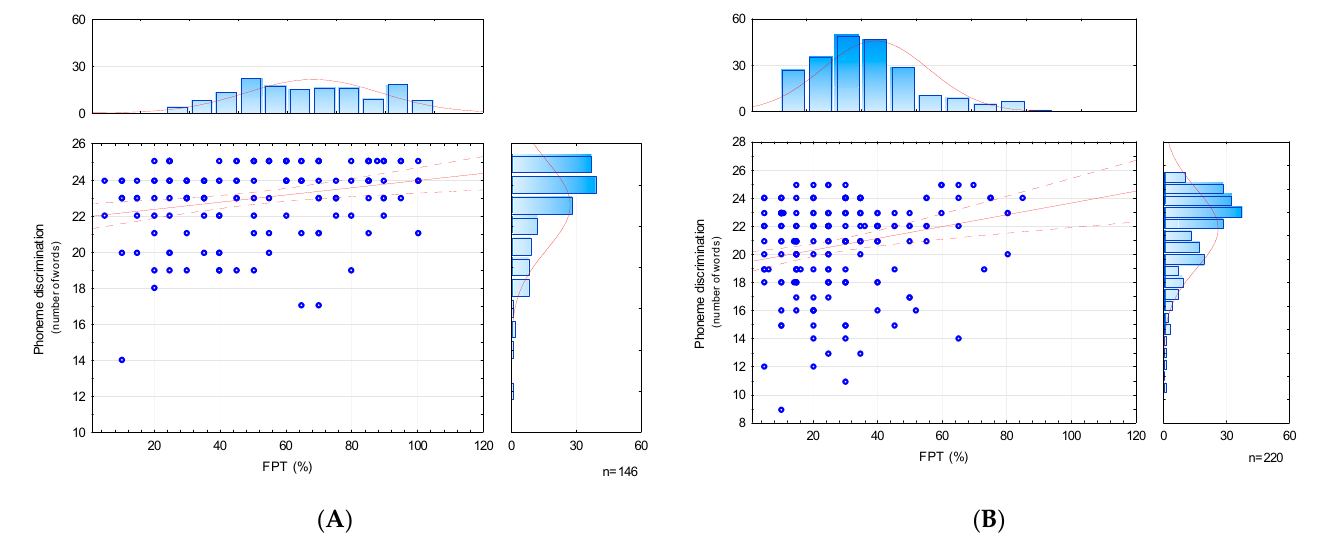
Figure 2. Correlation between Frequency Discrimination Test (FPT) and PDT results, ( A ) TD and ( B ) APD groups.